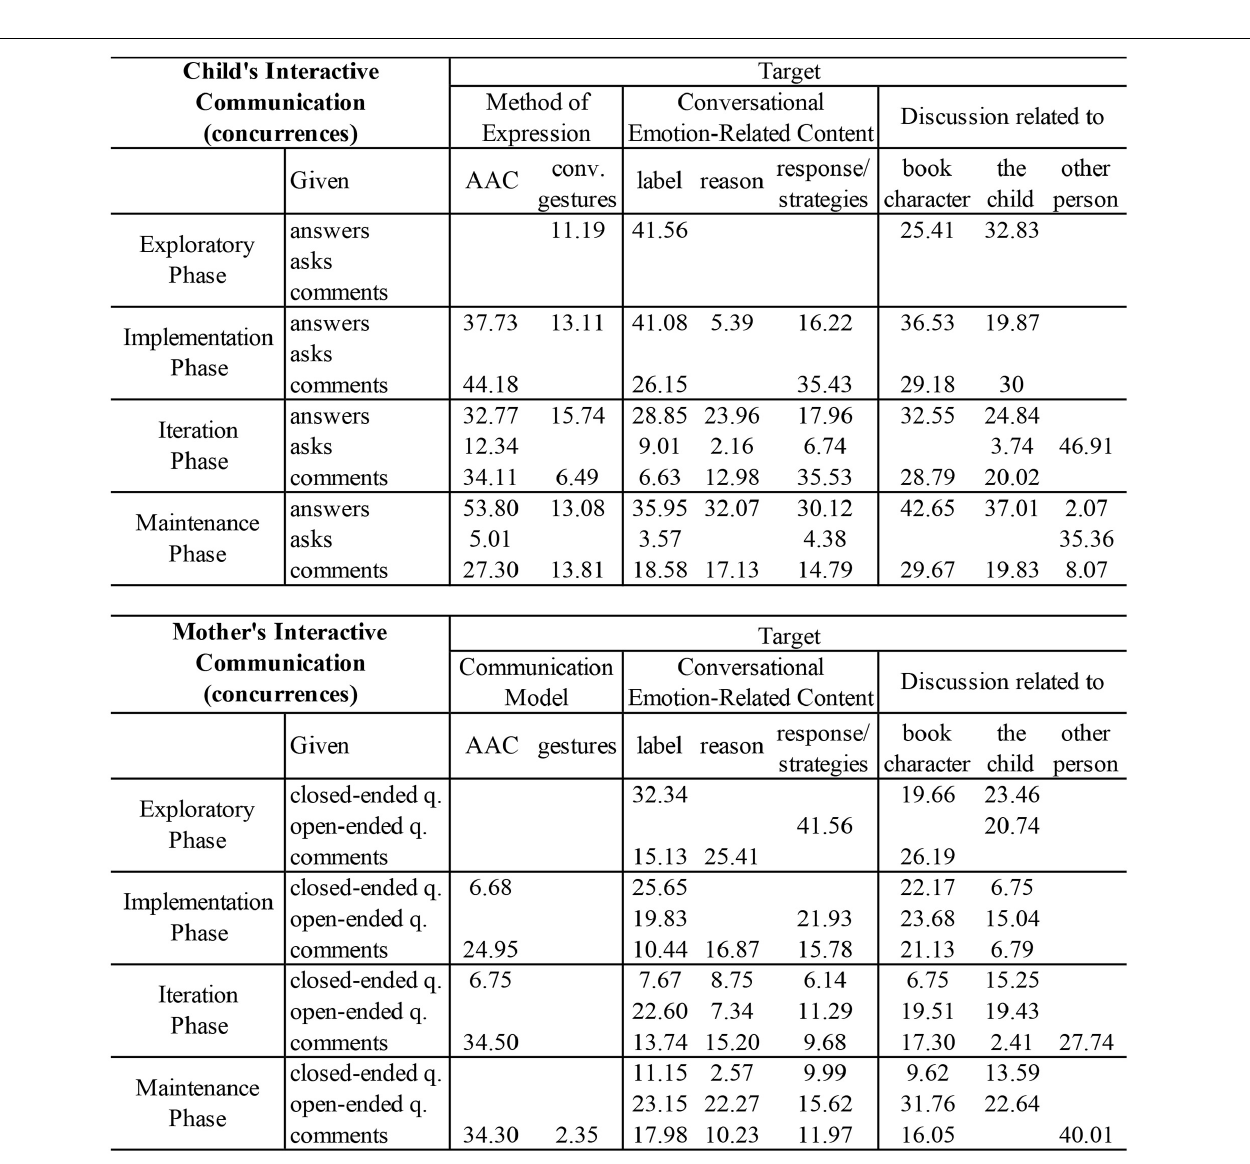
FIGURE 5 | Adjusted residuals showing significant concurrences (lag 0) between emotional conversations utterances from the mother and child, and their modes of expression, and type of emotional content discuss (content and related